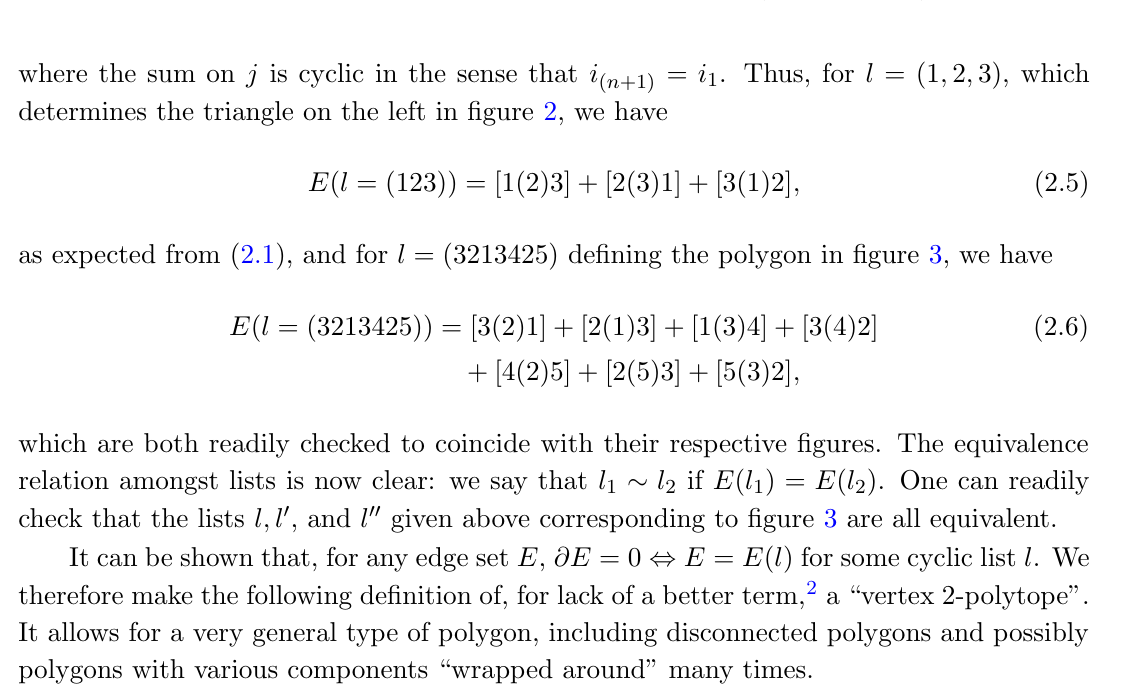
Figure 3 . The polygon corresponding to the list l = (3 ; 2 ; 1 ; 3 ; 4 ; 2 ;